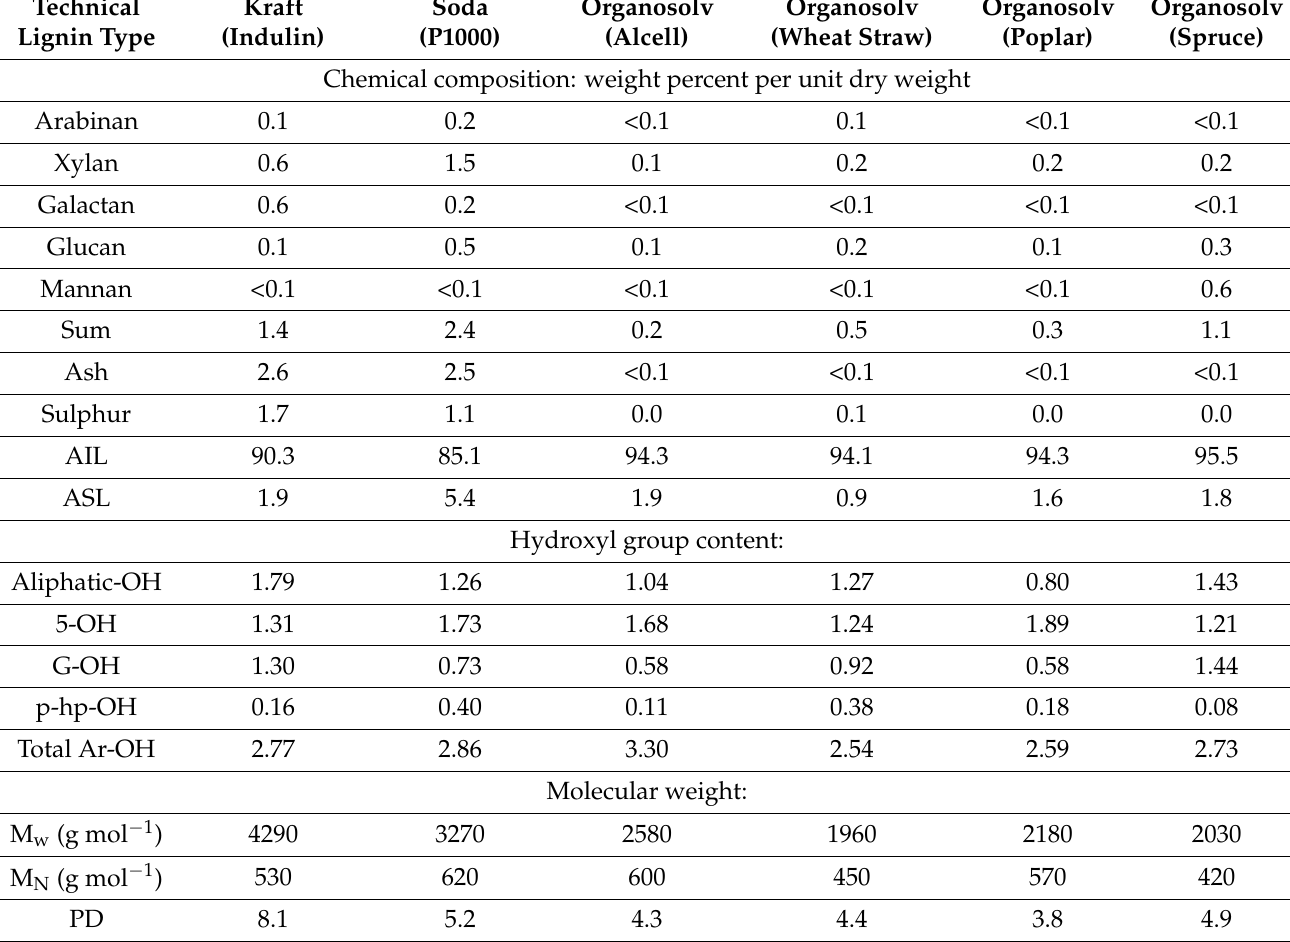
Table 3. Variation in chemical composition and characteristics of different technical lignins